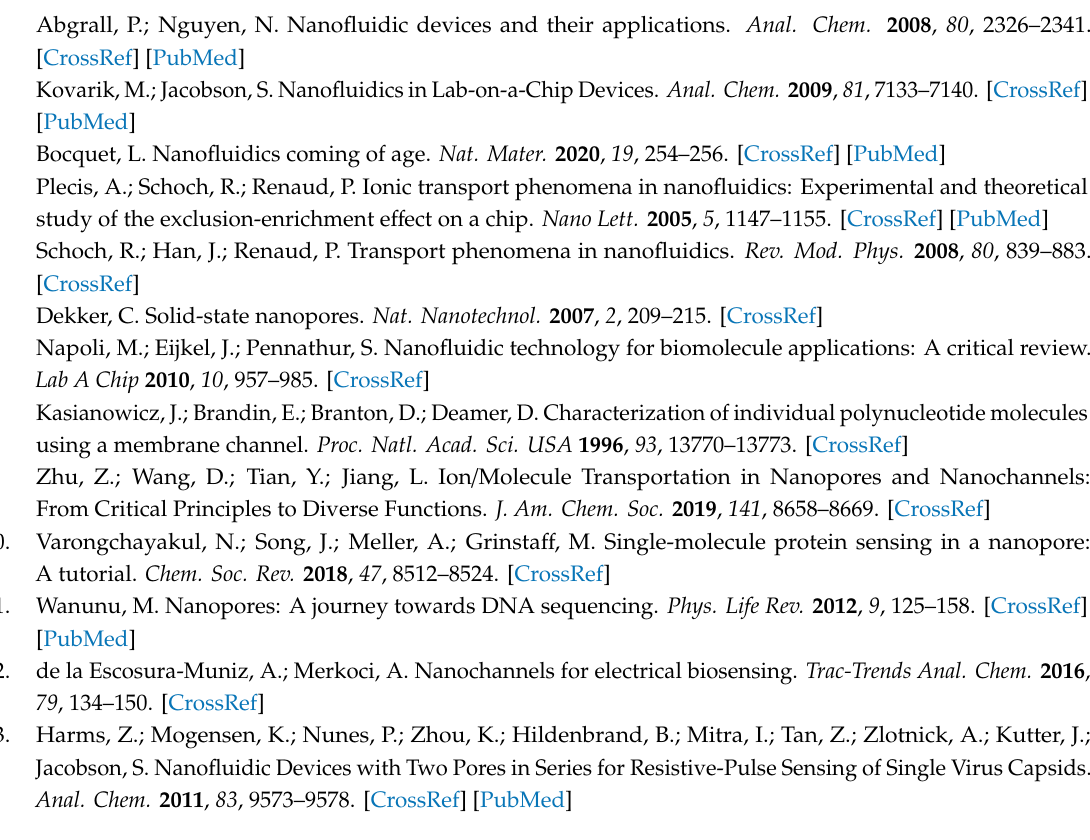
used in Comsol for the finite element calculations, Figure S2: description of the mesh used for simulations, Figure S3: comparison between the results obtained by PNP and PNP-NS equation systems, Figure S4: simulations performed considering neutral walls (no surface charge